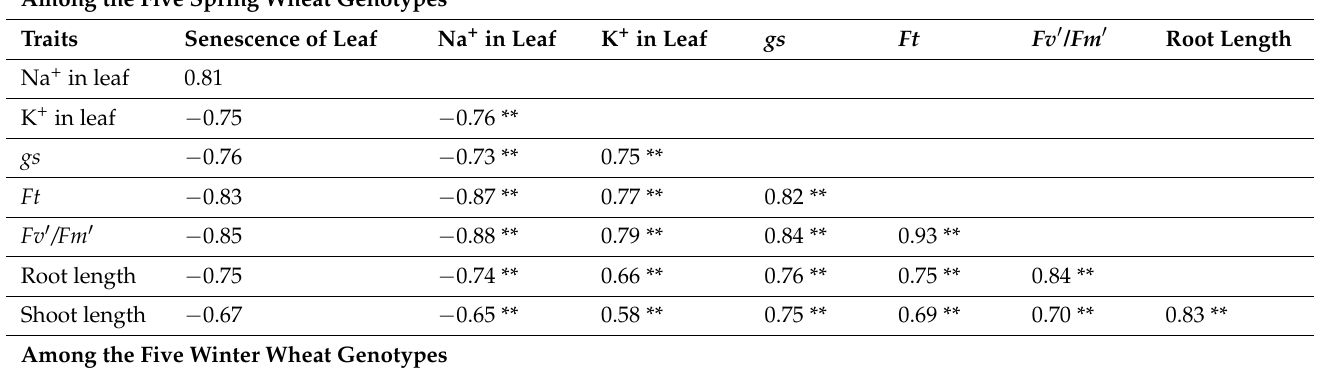
Table 2. Correlations among different ionic, growth, and physiological traits of wheat genotypes grown under various NaCl stress